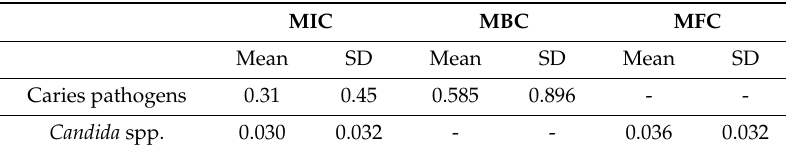
Table 4. The MIC, MBC, and MFC (%) of cinnamon EO against oral pathogens (mean and standard deviation